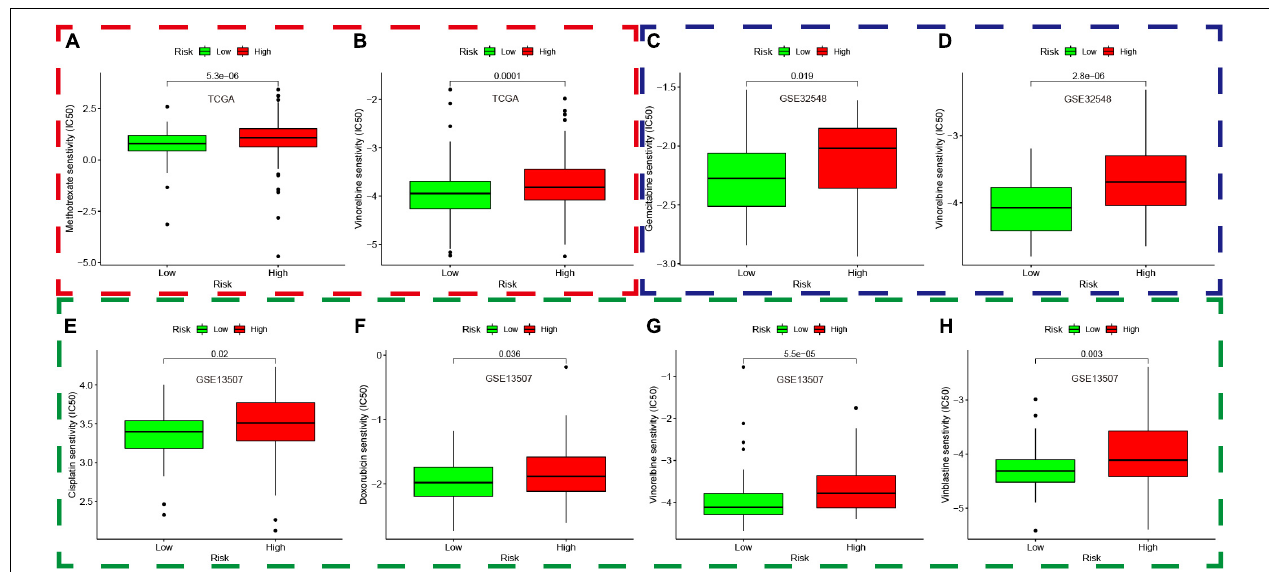
FIGURE 14 | Prediction of chemotherapy response based on the genomics of drug sensitivity in cancer. The red, green, and blue dashed boxes corresponded to the TCGA database, GSE13507, and GSE32548, respectively. (A,B) showed that the IC50 of methotrexate and vinorelbine in the high-risk group was significantly higher than that in the low-risk group in the TCGA dataset. Similarly, the IC50 of gemcitabine and vinorelbine was significantly higher in the high-risk group compared with that in the low-risk group in GSE32548 (C,D) , and the IC50 of cisplatin, doxorubicin, vinblastine, and vinorelbine was significantly higher in the high-risk group in GSE13507 (E–H)